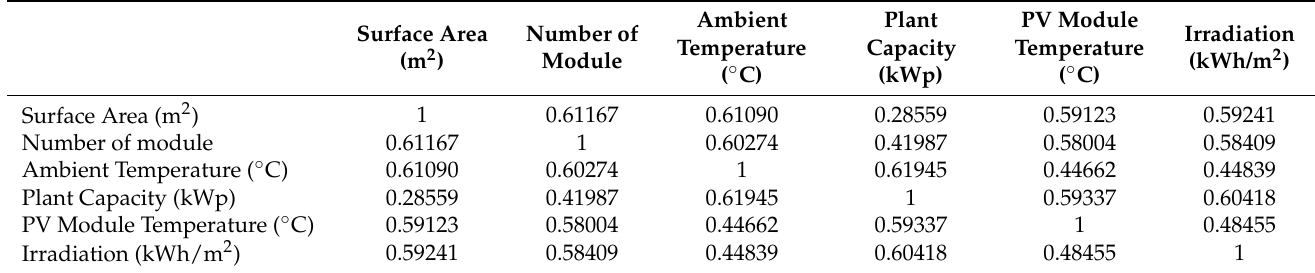
Table 4. Affinity Matrix.